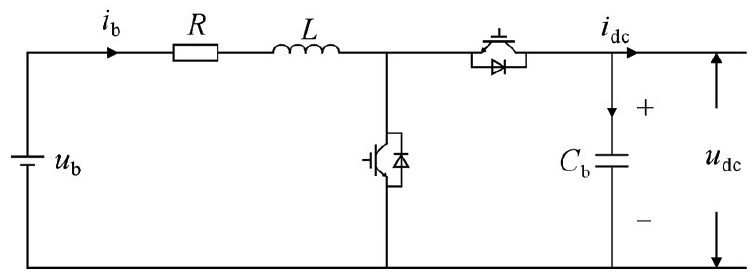
Figure 3. Buck-Boost Circuit